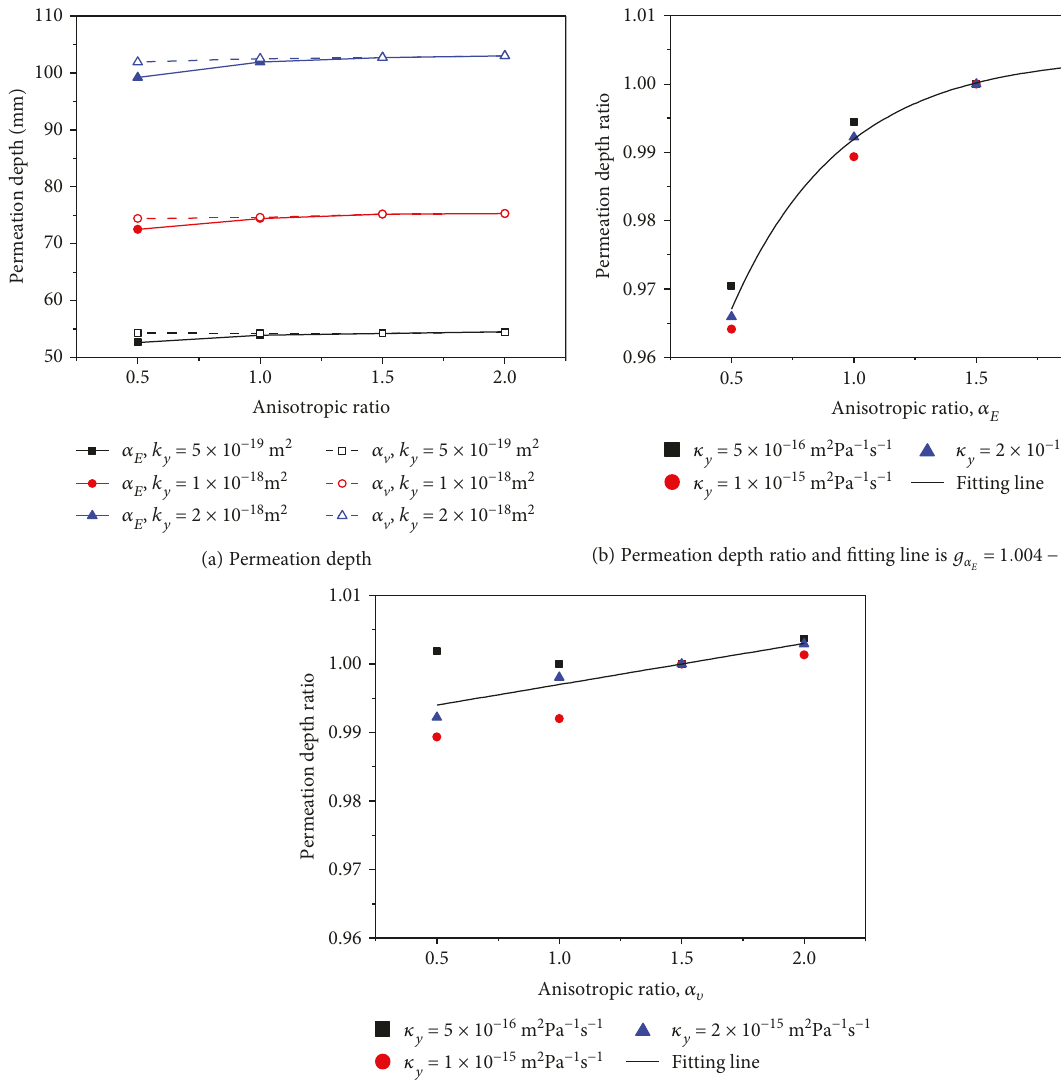
Figure 11: Changes of permeation depth and permeation depth ratio with mechanical anisotropic